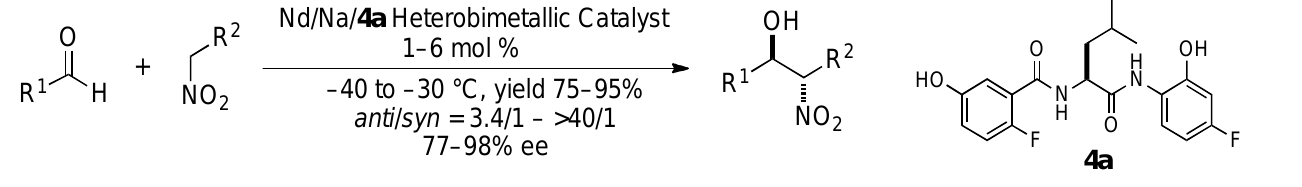
Table 1. Catalytic asymmetric nitro-Mannich reaction promoted by RE/alkali metal/ 4a heterobimetallic catalyst. a